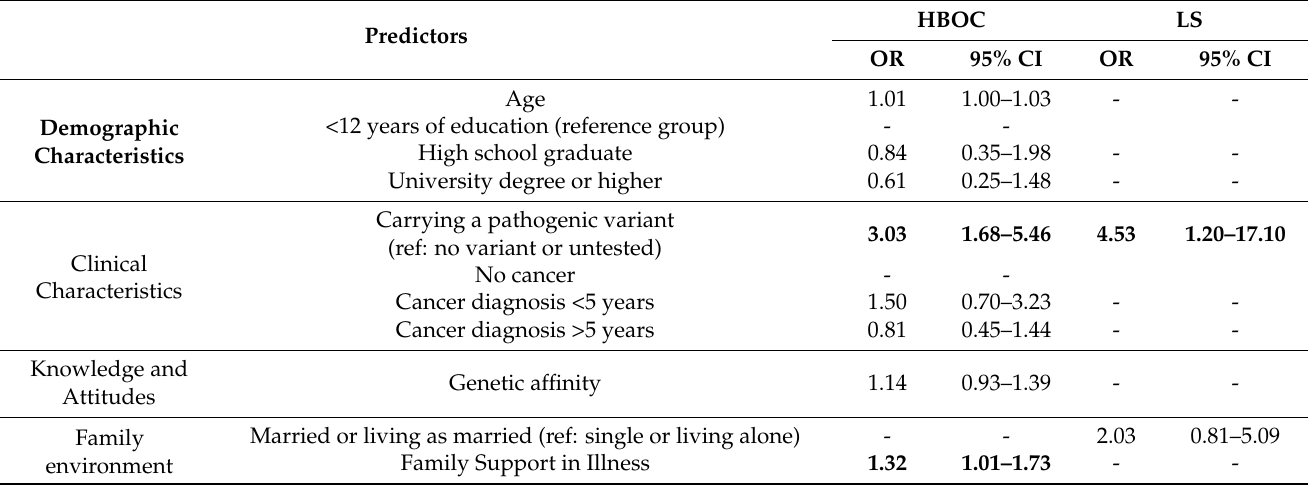
Table 3. Logistic regression fitted models of intention to invite at least one relative versus intention to invite no relatives for HBOC and for LS based on least absolute shrinkage and selection operator (LASSO) variable